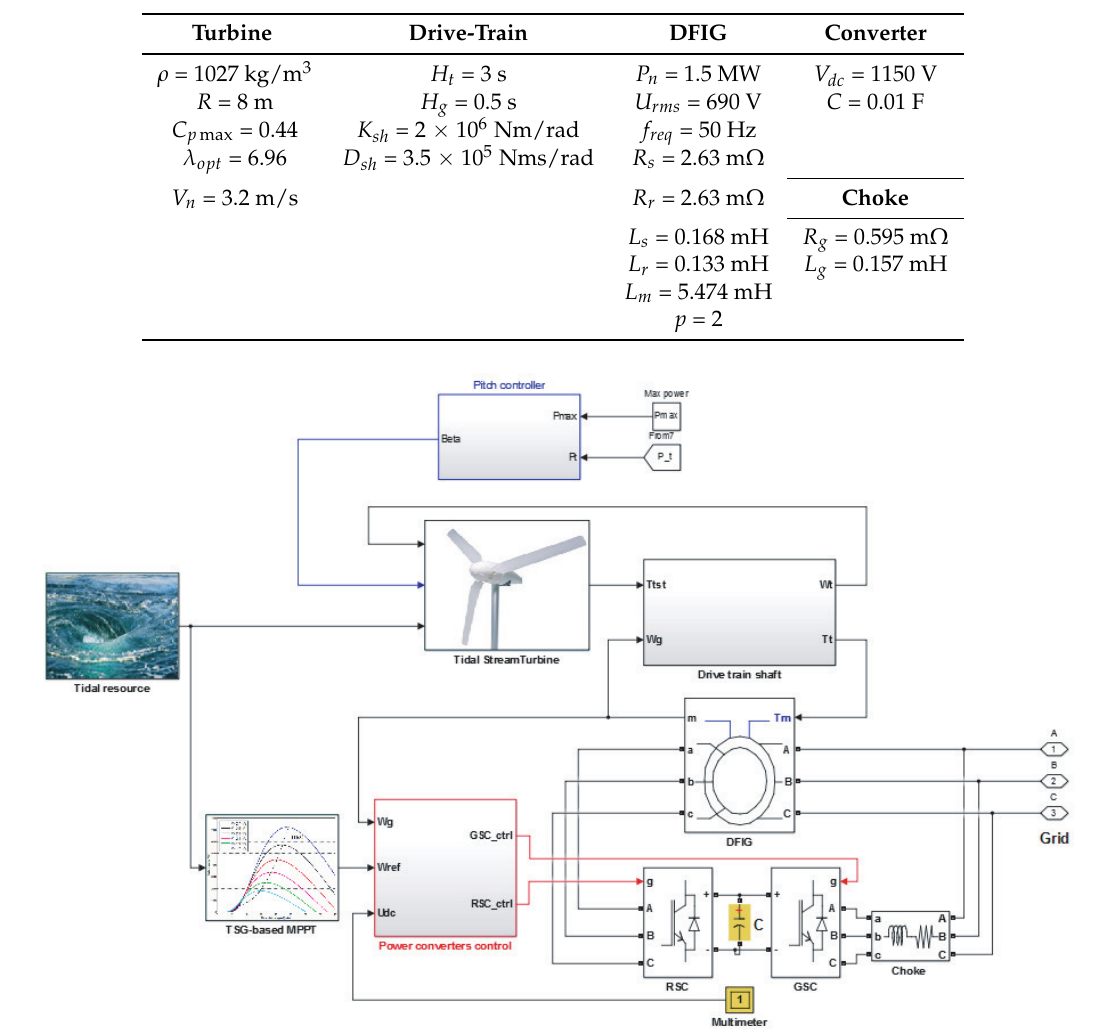
Figure 15. Model implementation of the TSG power